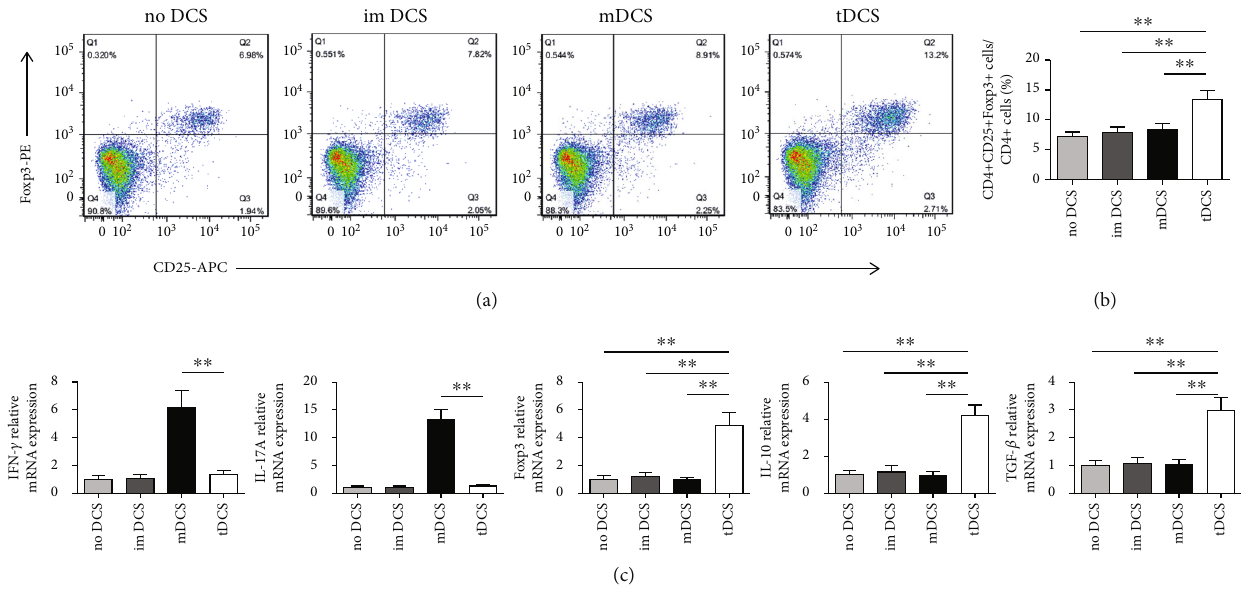
Figure 10: Interleukin (IL) – 27 plus lipopolysaccharide (LPS) – treated dendritic cells (DCs) display tolerogenic properties. (a) Bone marrow – derived DCs ( 2 × 10 5 cells/well) were cultured in the absence of stimulus (immature DCs [imDCs]) or in the presence of 100 ng/mL LPS (mature DCs [mDCs]) or 100ng/mL LPS and 30ng/mL IL-27 (tolerogenic DCs [tDCs]). DCs were stained with isotype control antibodies or with speci fi c antibodies against major histocompatibility complex class II (MHC-II), CD40, and CD86 and analyzed by fl uorescence-activated cell sorting (FACS). (b) Mean fl uorescence intensities (MFIs) for MHC-II, CD40, and CD86 were investigated. (c) Analysis of the mRNA levels in di ff erent DCs groups. n = 6 per group. ∗∗ P < 0 : 01